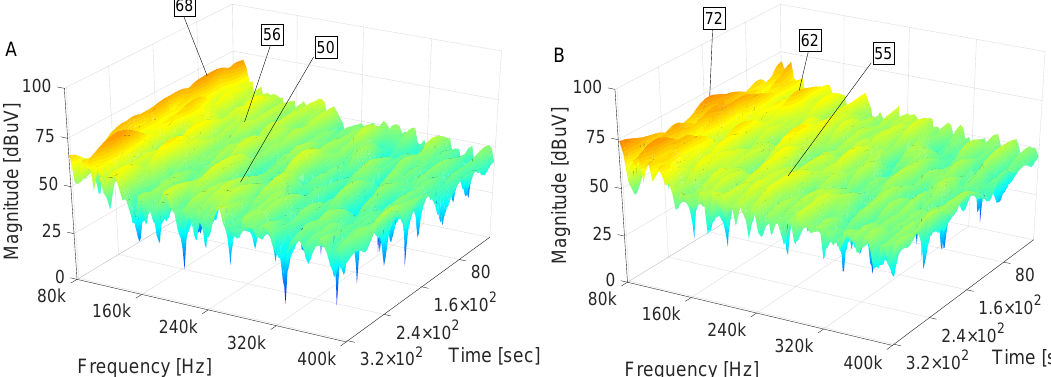
Figure 3. Simulation 3D spectrograms of interference caused by one DC/DC converter with RanM ( A ), and two DC/DC converters with RanM ( B ).